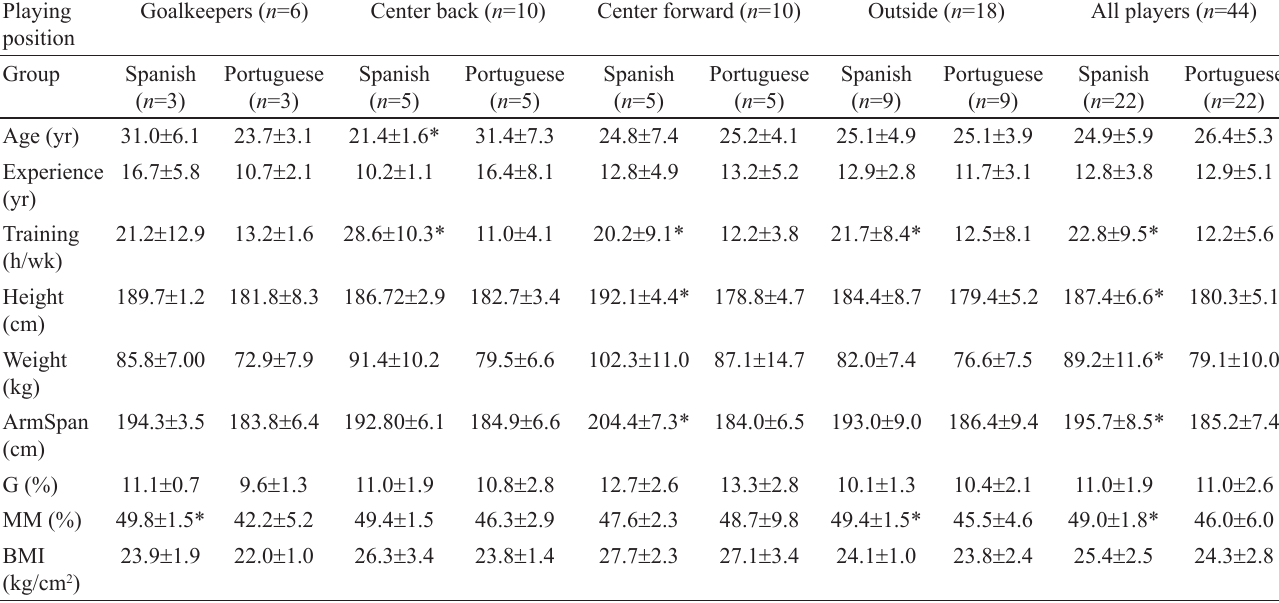
Mean ± SD values of the morphology and training background characteristics of Spanish and Portuguese waterpolo players for the total sample and by specialized playing